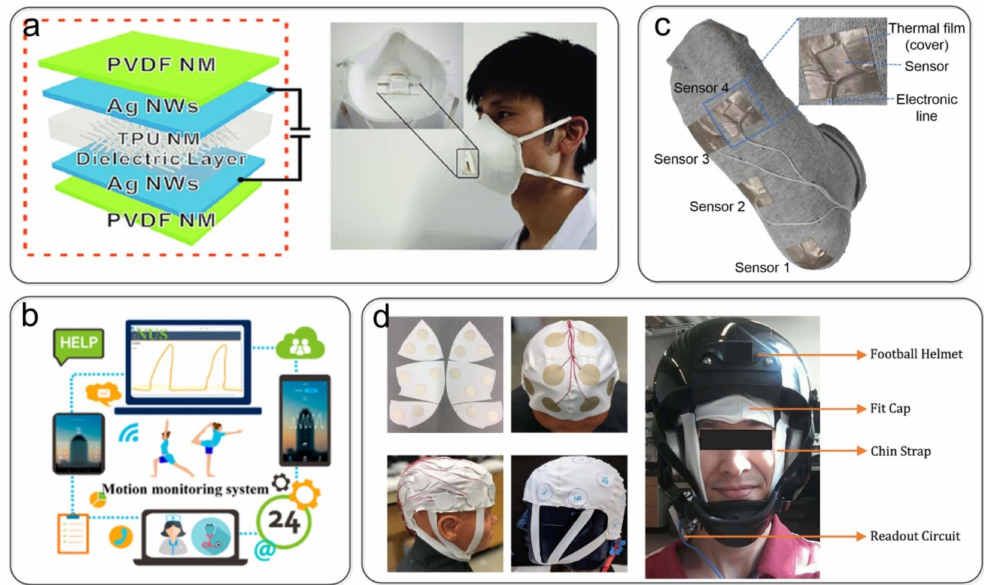
Figure 10. Pressure sensors are used in wearable devices. ( a ) All-textile-structured skin sensors monitor physiological signals, such as human breathing and heart rate. Reproduced with permission from Ref. [106]. Copyright 2017 Wiley-VCH. ( b ) All-textile pressure sensor and wireless batteryless monitoring system for real-time human movement detection. Reproduced with permission from Ref. [107]. Copyright 2019 American Chemical Society. ( c ) Capacitive textile pressure sensor for walking gait analysis. Reproduced with permission from Ref. [108]. Copyright 2020 Elsevier. ( d ) Ca- pacitive pressure sensing array composed of conductive fabric electrodes used to measure and map the pressure on a player’s head wearing a helmet. Reproduced with permission from Ref.